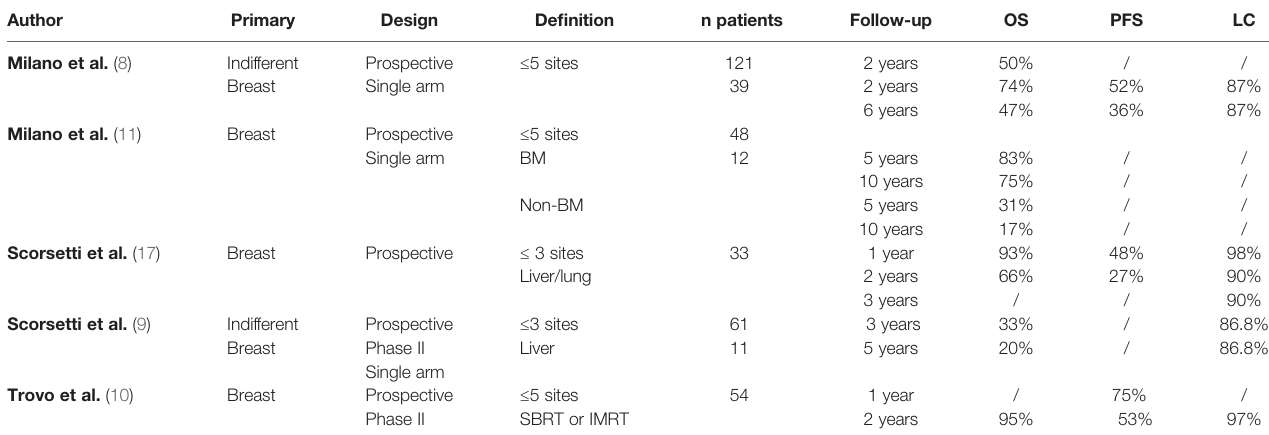
TABLE 5 | Review of the literature of different prospective trials on radiotherapy for oligometastases of breast